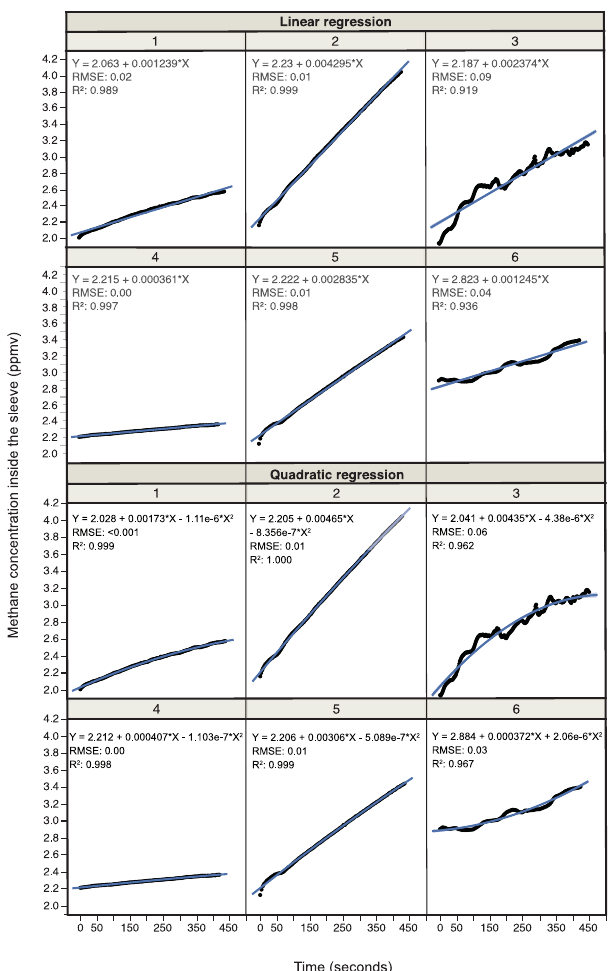
Figure 6. Contrasting methane concentration changes in the semi- rigid sleeve from enclosed gas samples measured in continuous flow mode (UGGA) from tree stems. In the first six runs (top quadrants) the concentration changes were regressed with a linear fit, while in the second set of runs (bottom quadrants) they were regressed with quadratic fit (non-linear). Runs 1, 2, 3, and 5 were made on Betula pendula stems, runs 4 and 6 were made on Pinus sylvestris stems, runs 3 and 6 show the concentration responses in situations where the sleeves were leaking. The blue line corresponds to 95% confi- dence intervals, RMSE = root mean square error, R 2 = coefficient of determination, Y = methane concentration in